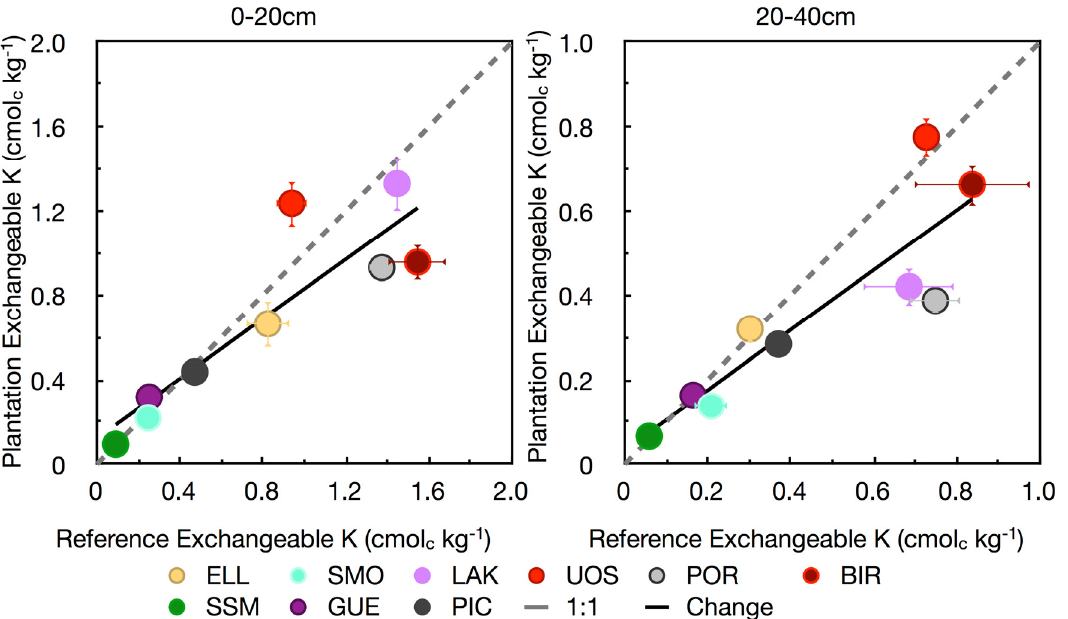
Figure 4. Initial concentration of exchangeable K, as estimated from reference sites, versus exchangeable K concentration in plantations after the first rotation of nine S. purpurea “Hotel” plantations (ELL, SMO, LAK, UOS, POR, BIR, SSM, GUE, and PIC). Error bars represent standard error when greater than symbol